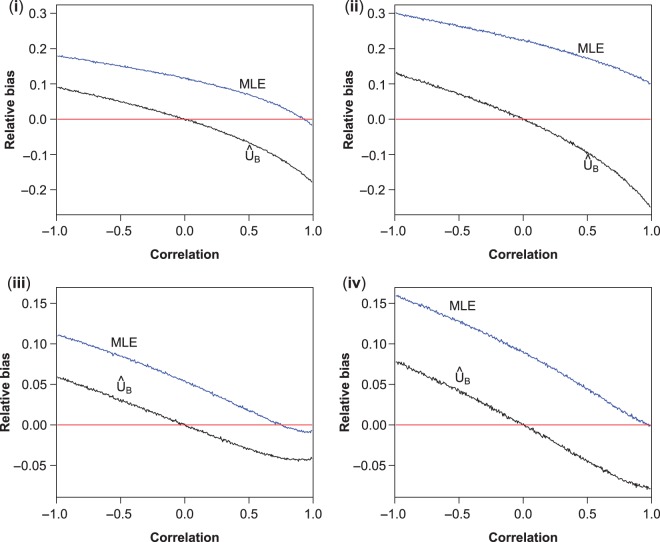
Mean relative bias of the MLE (\documentclass[12pt]{minimal}
\usepackage{amsmath}
\usepackage{wasysym}
\usepackage{amsfonts}
\usepackage{amssymb}
\usepackage{amsbsy}
\usepackage{upgreek}
\usepackage{mathrsfs}
\setlength{\oddsidemargin}{-69pt}
\begin{document}
}{}$\hat {\mu }_1$\end{document}, blue), and the UMVCUE (\documentclass[12pt]{minimal}
\usepackage{amsmath}
\usepackage{wasysym}
\usepackage{amsfonts}
\usepackage{amssymb}
\usepackage{amsbsy}
\usepackage{upgreek}
\usepackage{mathrsfs}
\setlength{\oddsidemargin}{-69pt}
\begin{document}
}{}$\hat {U}_B$\end{document}, black) that ignores the correlation. Plots show the mean of 100 000 simulations for each value of \documentclass[12pt]{minimal}
\usepackage{amsmath}
\usepackage{wasysym}
\usepackage{amsfonts}
\usepackage{amssymb}
\usepackage{amsbsy}
\usepackage{upgreek}
\usepackage{mathrsfs}
\setlength{\oddsidemargin}{-69pt}
\begin{document}
}{}$\rho $\end{document}. The horizontal line shows where the bias equals zero.